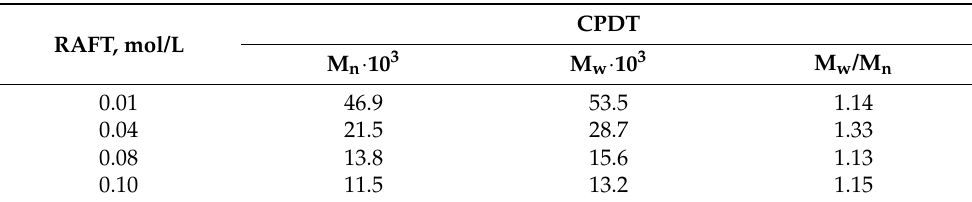
ysis was 77.87 ± 1.65%. rophages) was tested using polyMAA (system 1: M n ∙ 10 3 = 16.0, M w /M n = 1.47; system 2: Table 2. Molecular weight characteristics of polyTBMA synthesized in the presence of CPDT, M n ∙ 10 3 = 99.2, M w /M n = 1.57; and system 3: M n ∙ 10 3 = 19.0, M w /M n = 1.45) and TBMA–MAA AIBN = 0.002 mol/L, T = 70 ◦ C. RAFT, mol/L